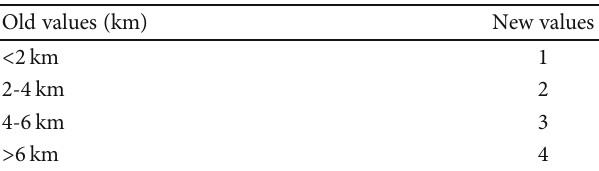
Figure 5: Suitable land use, land cover for solar PV. Table 10: Town reclassi fi